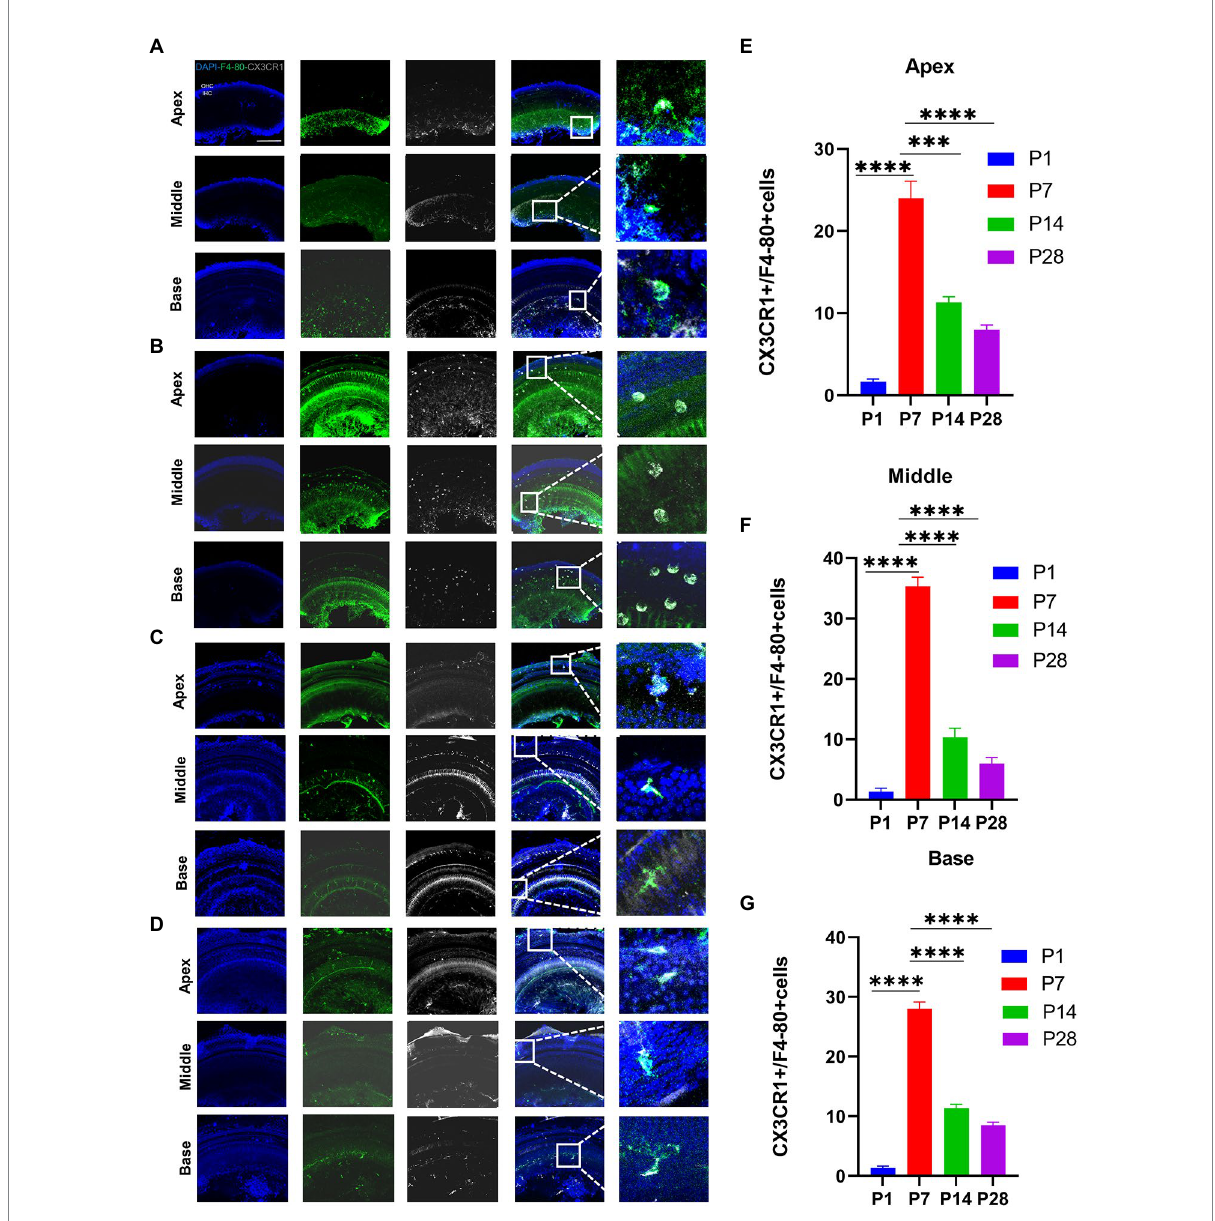
FIGURE 3 Detection of the number of CX3CR1 + macrophages during cochlear development from P1 to P28 in postnatal mice. (A) Immunofluorescence staining is used to detect the number of CX3CR1 + macrophages and identify the dynamic changes in the number of macrophages in P1. CX3CR1 (grey) colocalized with f4-80 (green). The nuclei are stained with DAPI. (B) Immunofluorescence staining is used to detect the number of CX3CR1 + macrophages and identify the dynamic changes in the number of macrophages at P7. (C) Immunofluorescence staining is used to detect the number of CX3CR1 + macrophages and identify the dynamic changes in the number of macrophages at P14. (D) Immunofluorescence staining is used to detect the number of CX3CR1 + macrophages and identify the dynamic changes in the number of macrophages at P28. Scale bar = 50 μ m, n = 3. The image on the right is an enlarged image on the left. (E–G) Quantitative analysis of the number of CX3CR1 + macrophages from P1 to P28 showing that the number of CX3CR1 + macrophages from the apical to the middle to the basal turn of the cochlea is significantly higher on P7 than on P1, P14, and P28. ** p < 0.01, *** p < 0.001, **** p <